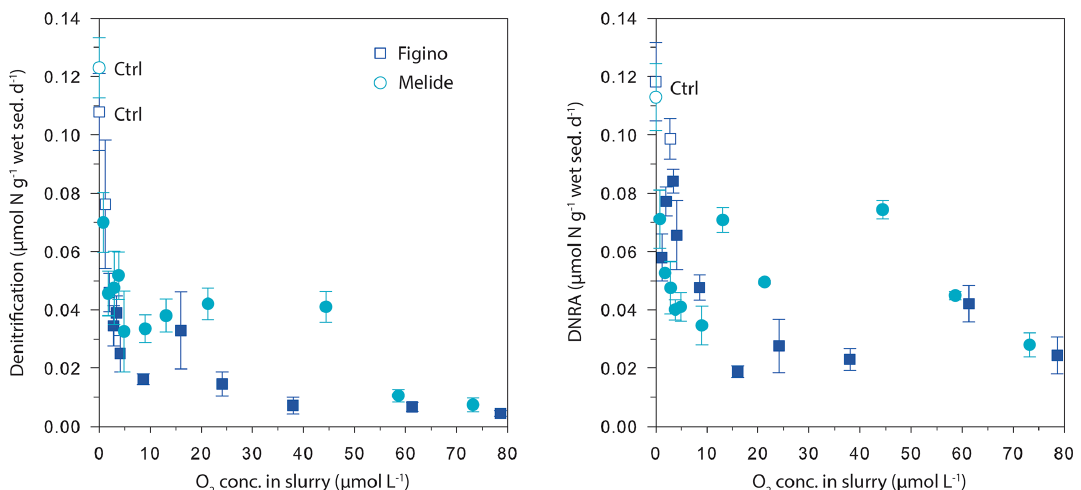
Figure 3. Denitrification and DNRA rates as a function of dissolved O 2 concentration in dilute sediment slurry from Figino and Melide. Statistically significant differences between denitrification/DNRA rates measured in the different O 2 treatments versus those in the respec- tive control (Ctrl) experiments are shown by the filled symbols ( P< 0 . 05, Table S2). Error bars represent the standard error of n replicate experiments and measurements (Table 1).